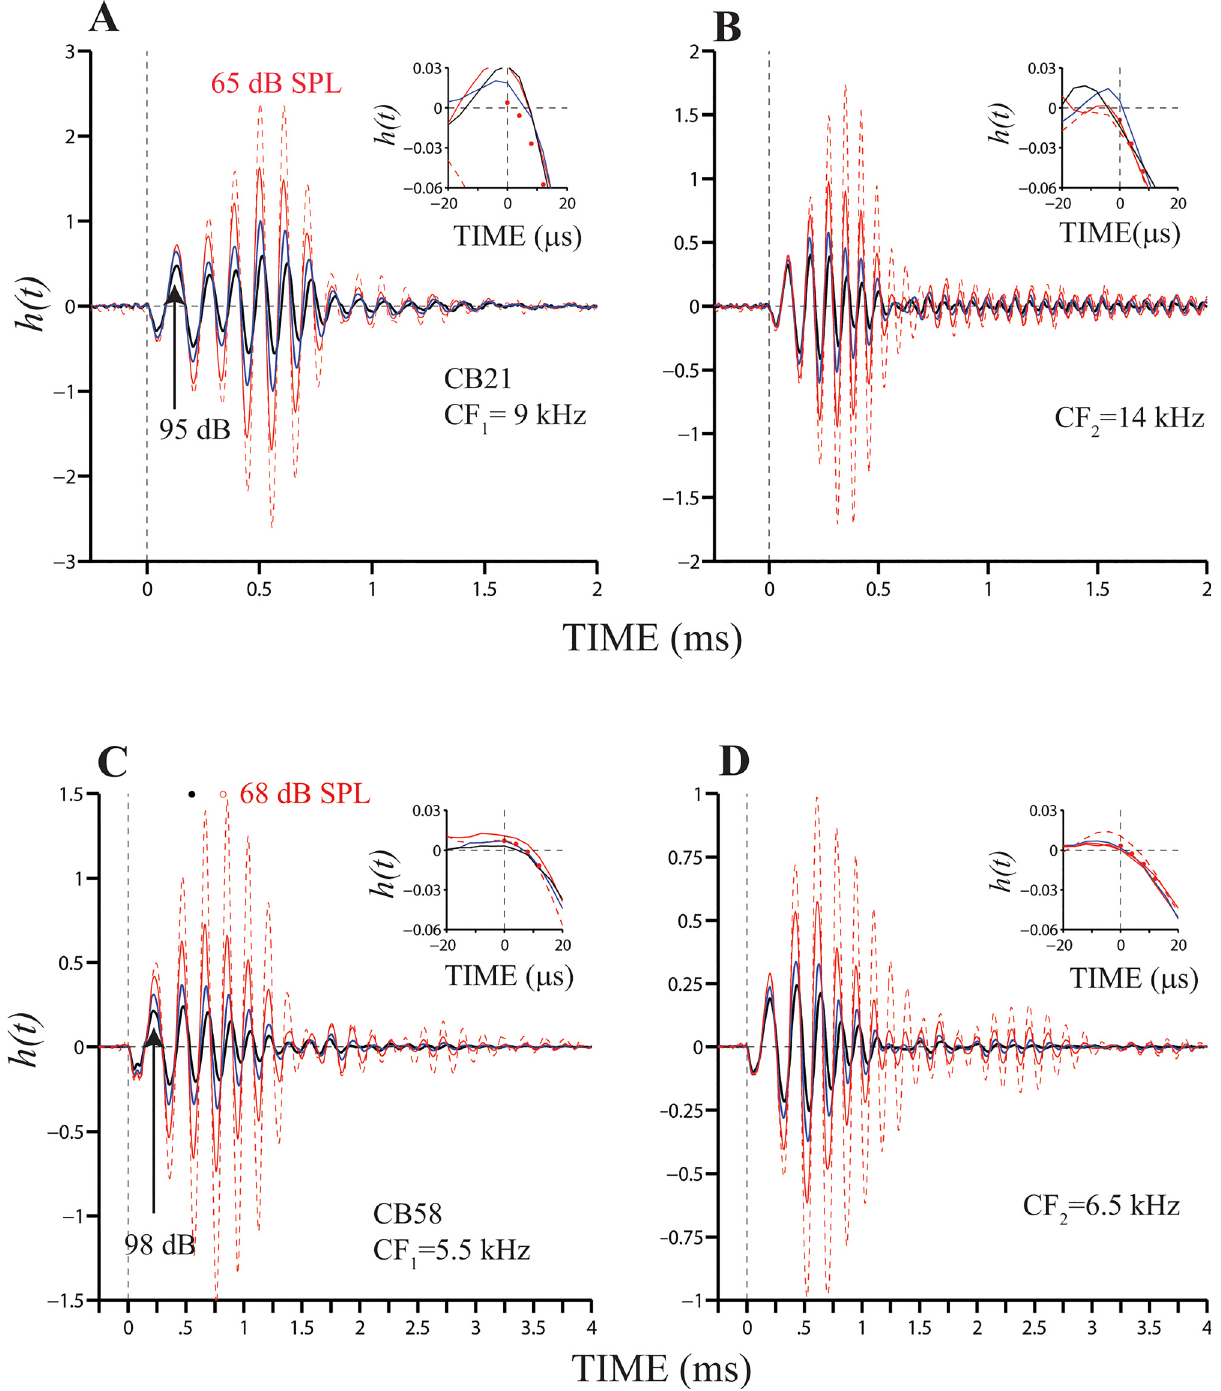
Fig 5. h ( t ) functions at several cochlear locations. Gain functions were computed from BM and umbo responses to clicks at four intensity levels. Results in (A) and (B) originate from data recorded at two location in the same cochlea. (Likewise for results in (C) and (D).) CFs and stimulus levels are shown in each panel. Insets display fragments of each gain function, from -20 to 20 μ s. Red filled circles in each panel represent the average of each set of four h ( t ).